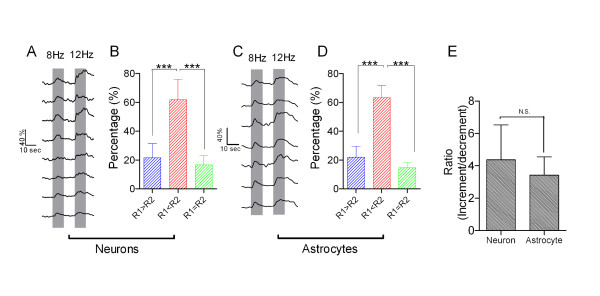
Barrel network neurons and astrocytes show a dominant increment in responses to the frequency increase of paired whisker stimuli. A) shows two sequential Ca2+ signals at the barrel neurons (a trace per cell) in response to paired burst-stimili at 8-to-12 Hz. B) The percentages of the three patterns among barrel network neurons (n = 5 mice) in response to 8-to-12 Hz stimuli show the increment in dominance. C) Ca2+ signals in astrocytes are evoked by the paired burst-stimuli (gray bars) in 8-to-12 Hz. D) The increment in pair-responses (R1 versus R2) from astrocytes is dominant when the paired stimuli in 8-to-12 Hz are given. E) The ratio of increment pattern to decrement patterns shows no significant difference between neuronal network and astrocytic network. Three asterisks indicate p < 0.001, N.S. means no significant difference, student’s t-test.